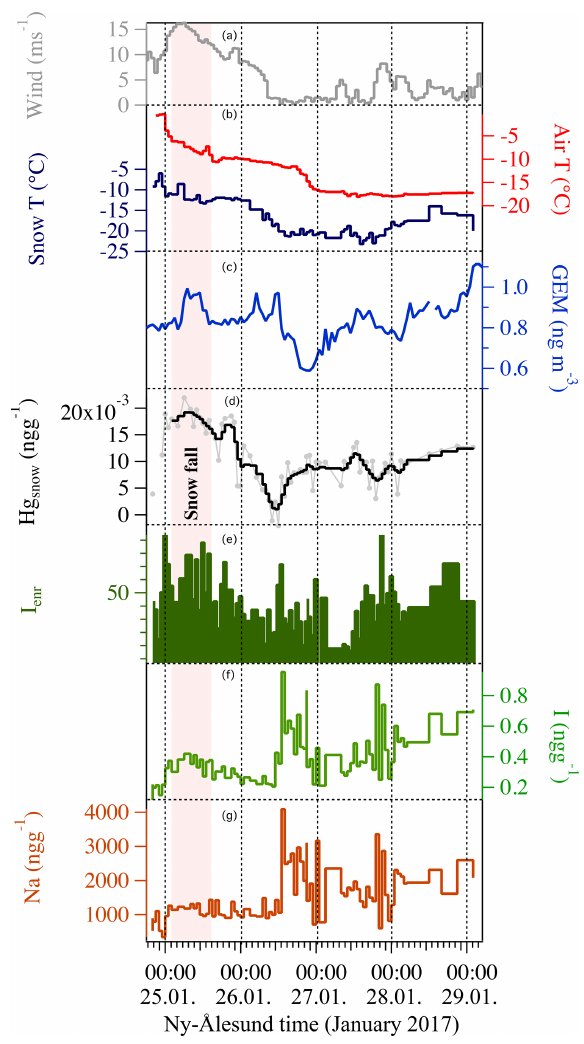
Figure 5. The 2017 experiment was conducted during the polar night. Iodine concentration ( f – green line) correlated with sodium concentration ( g – dark red line). The iodine enrichment factor ( e – dark green solid line) did not exhibit any diurnal cycle and had the higher value compared to the three experiments. Gaseous elemental mercury ( c – blue line) and the surface snow total mercury con- centrations did not exhibit any diurnal pattern ( d – light grey line for raw data and black line for three-point smoothed). Snow and air temperature ( b – dark blue and red) did not show any diurnal cycle. Wind speed (a) is shown in grey. Dashed vertical lines indicate local